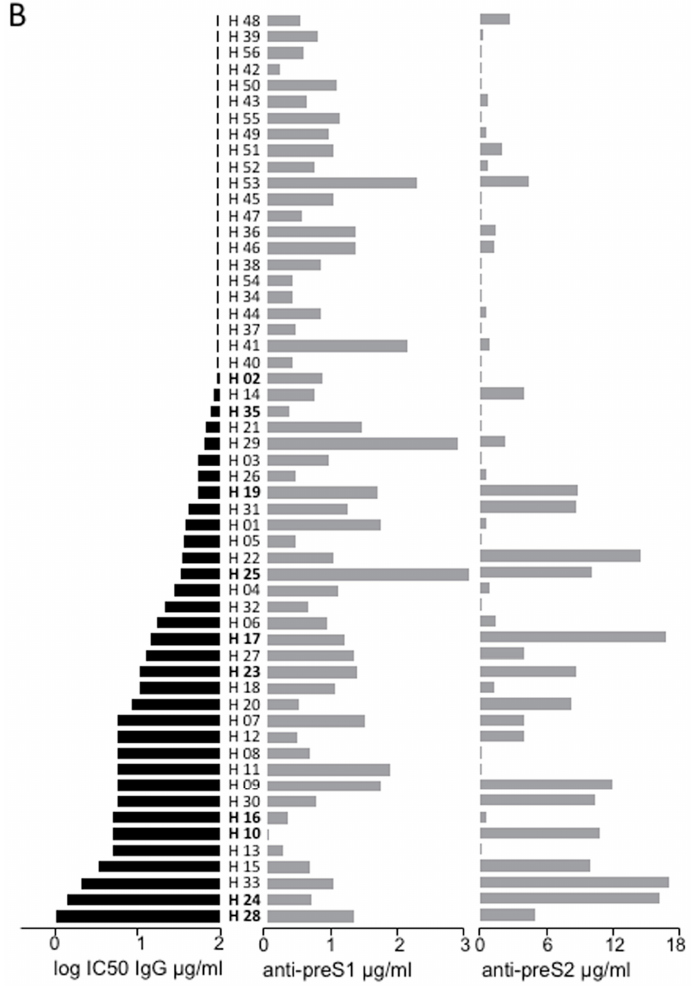
Figure 2. ( A ) Anti-HBs ELISA titers are not directly related to in vitro neutralization of HDV infectivity. Comparison of HDV neutralization activity (black histograms) of anti-HBs antibodies with their ELISA titers (gray histograms) in preparations of IgG purified from recipients of Hevac-B vaccine (H 01 to 56), Engerix-B vaccine (E 01 to 14), and Genehevac-B (G 01 to 19) and from individuals who recovered from infection (R 02 to 42). The IC50 was calculated using GraphPad Prism and expressed in µ g of IgG/mL. Anti-HBs antibody titers are expressed in mIU/ µ g of purified IgG. ( B ) Comparison of HDV neutralization activity (black histograms) of Hevac-B elicited antibodies with the ELISA titers (gray histograms) specific for anti-HBs, anti-preS1, and anti-preS2 antibodies in IgG preparations. The IC50 was calculated using GraphPad Prism and expressed in µ g of IgG per mL. Anti-HBs antibody titers are expressed in mIU/ µ g of purified IgG. Anti-preS1 and anti-preS2 ELISA titers are expressed in equivalent of µ g of purified R271 and R272 IgGs per mL,